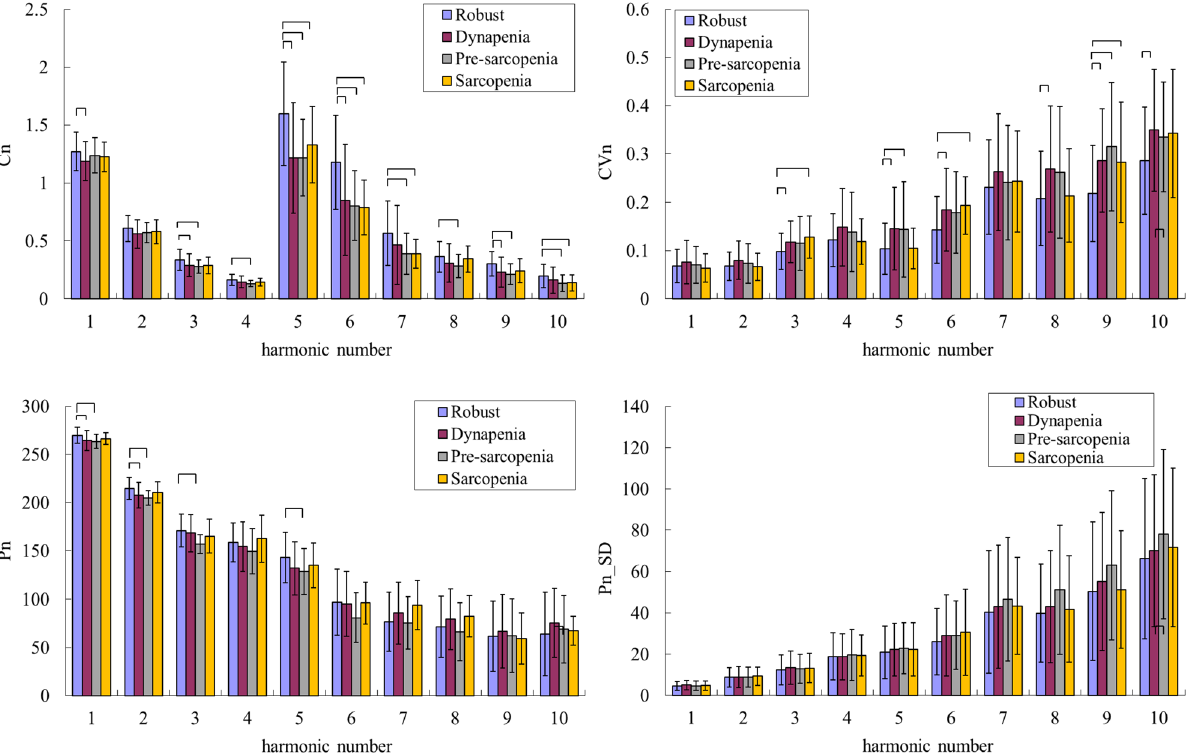
Figure 2. Comparisons of BPW harmonic indices among robust, dynapenia, presarcopenia, and sarcopenia: C n , CV n , P n , and P n _ SD . Data are mean and SD values. C 5 – C 10 values have been multiplied by 10 to make the differences clearer. “ (cid:6437) ” indicates p <